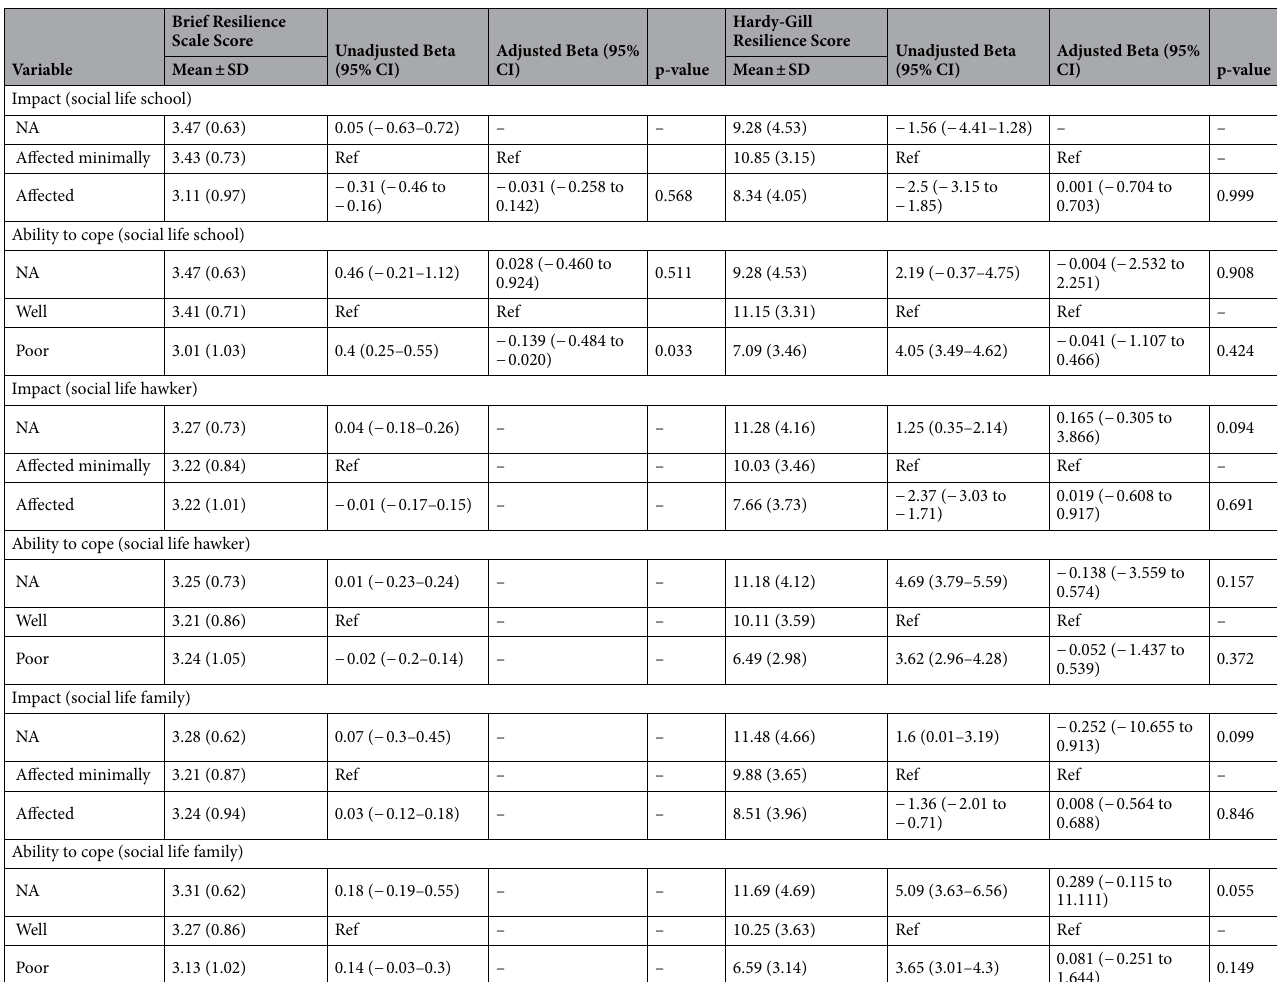
Table 6. Association between social life and resilience score. *p < 0.05. Model for BRS is adjusted for ethnicity and housing type. Model for HGRS is adjusted for gender, nationality, ethnicity and education